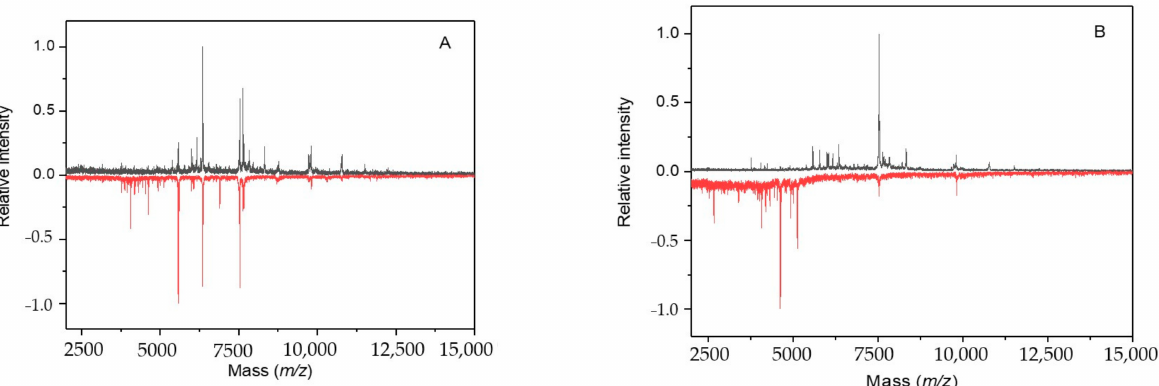
Figure 4. IC MALDI-TOF MS of Synechococcus sp. UPOC S4 grown in the presence of sodium azide. The spectra were acquired on Microflex LRF20 MALDI-TOF instrument using the dried-droplet sample preparation technique with FASA binary matrix. Subfigures ( A , B ) show results after cultivation with 10 µ M azide for 2 and 3 weeks, respectively: top spectrum in black—control; bottom spectrum in red—treated cells (intensities are multiplied by − 1 for